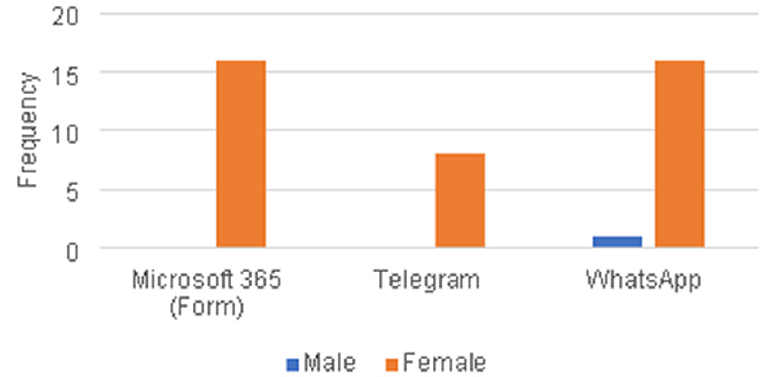
Fig. 3. Teaching and learning platform preference by gender